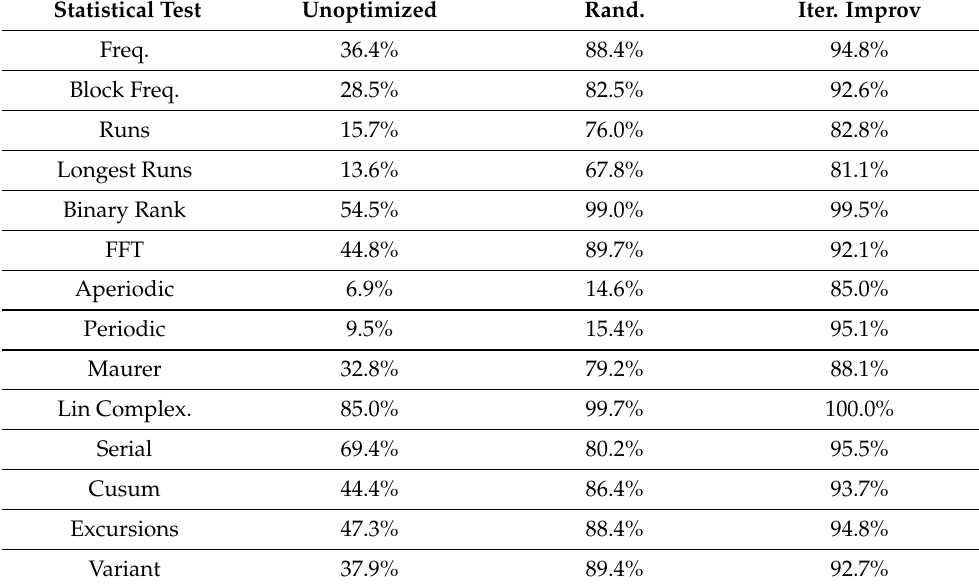
Table 8. Percentage of 1000 IPN instances that pass the NIST test suite on the test IPN. Each configuration collects 10,000-bit result and the maximum number of iterations is set to 1000.